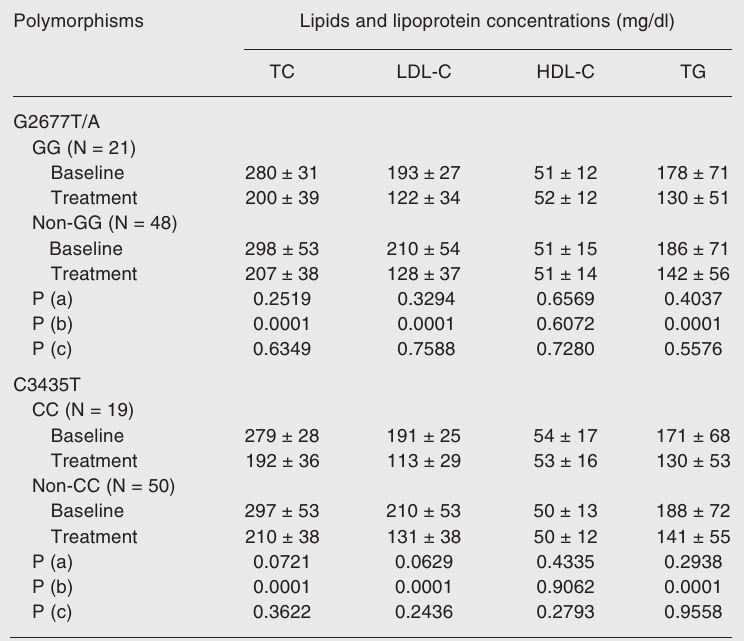
Figure 1. Concentrations of se- rum total cholesterol (A) and low- density lipoprotein (LDL) choles- terol (B) according to MDR1 hap- lotype in Brazilian hypercholes- terolemic individuals of European descent before (baseline) and af- ter atorvastatin treatment (10 mg/ day). T/T carriers: GT/CT, GT/TT, TT/CT, TT/TT, TA/CT haplo- types; non-TT carriers: GG/CC, GG/CT, GG/TT, GT/CC, GA/CC haplotypes. Horizontal lines in box plots represent the mean concentration of total cholesterol or LDL cholesterol. Repeated measures ANOVA/Tukey